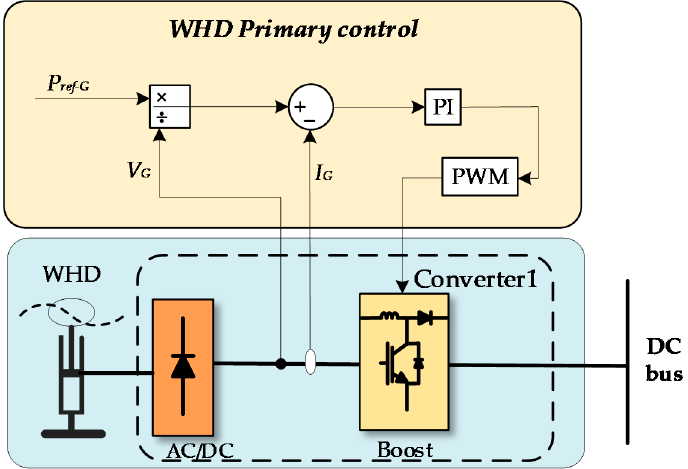
Figure 3. Primary control structure of WHD.